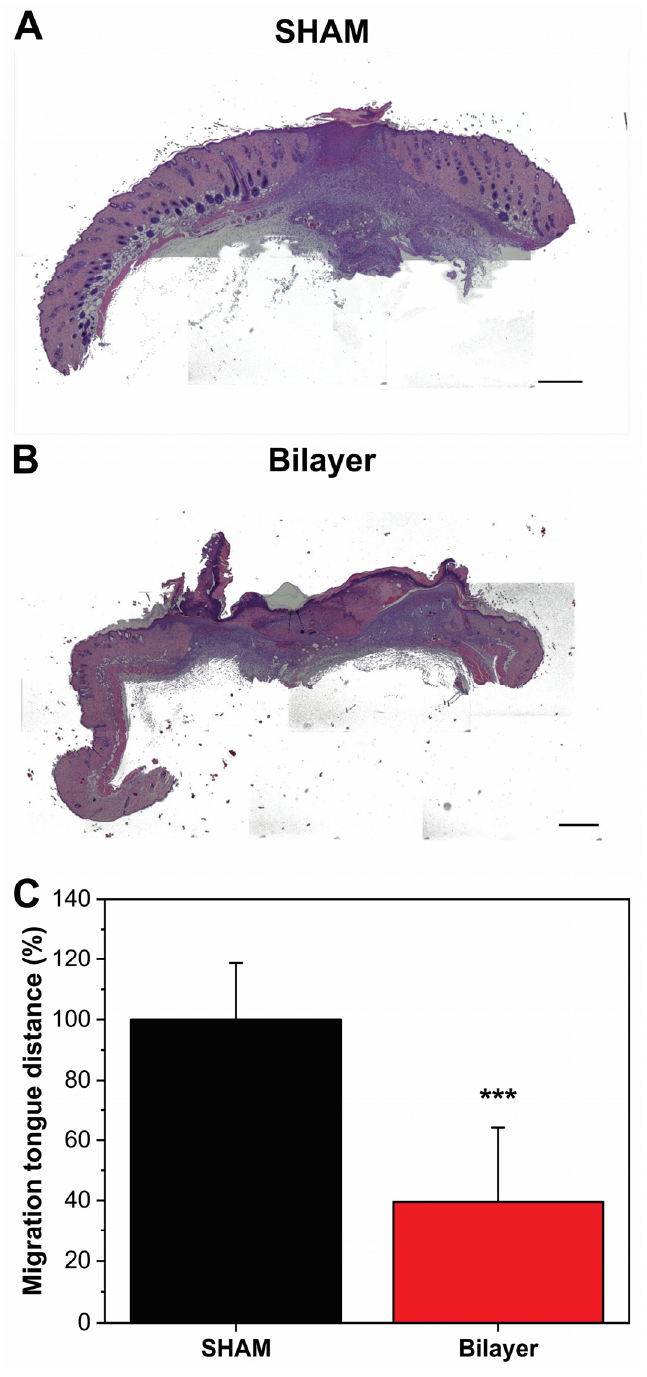
Figure 8. ( A , B ) , Hematoxylin-eosin staining of skin sections from diabetic untreated and treated mice (scale bars, 200 μ m) 7 days after wound induction. ( C ) , Migrating tongues distances